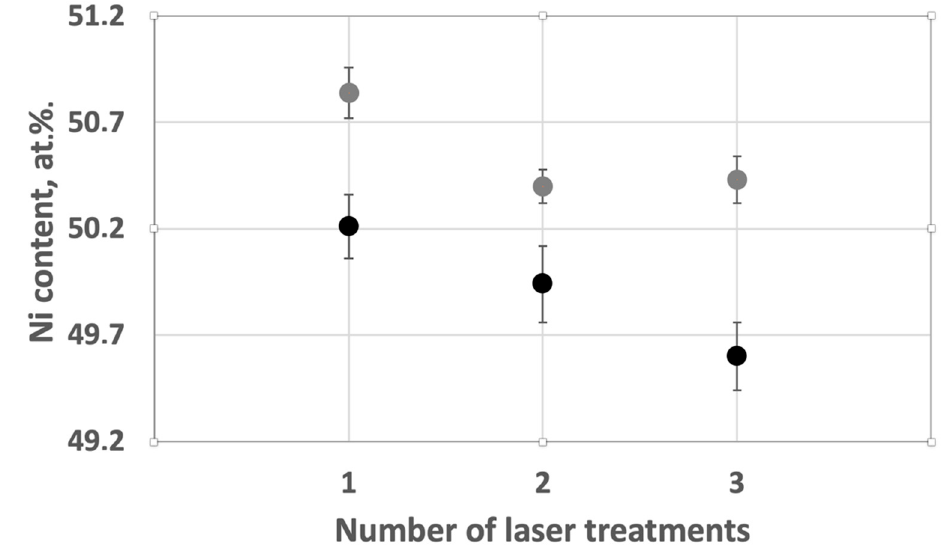
Figure 3. Dependence of the Ni content in compact samples on the number of laser treatments. Black dots—50.0, gray dots—50.7.